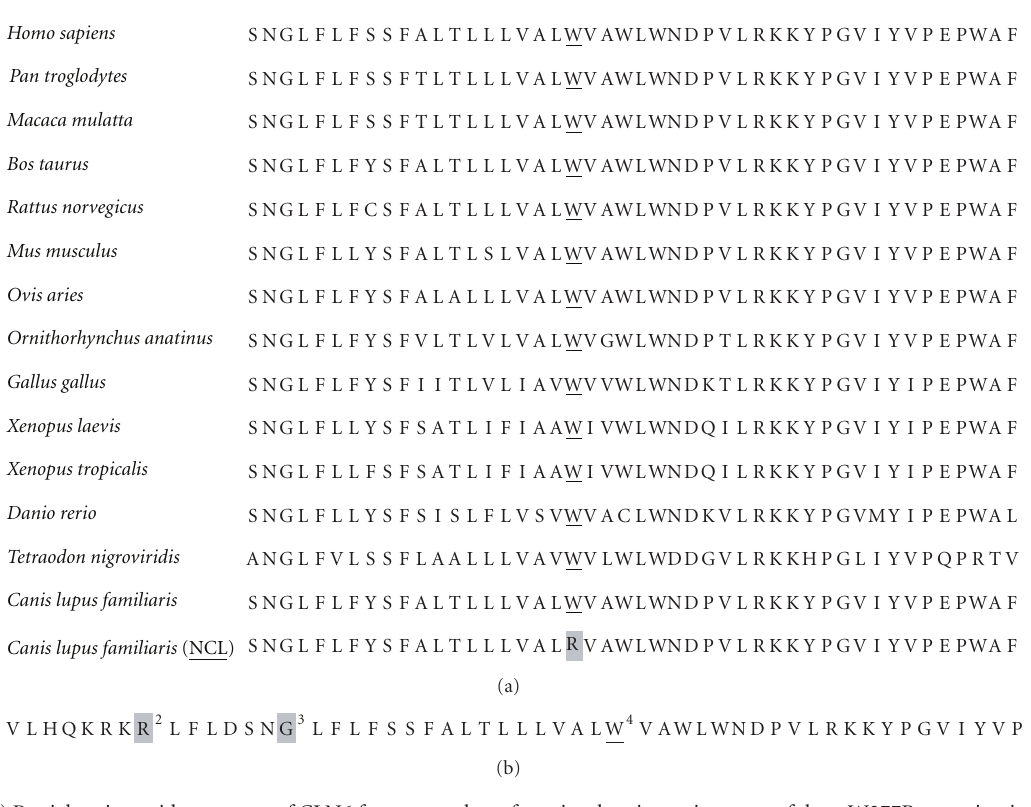
Figure 4: (a) Partial amino acid sequences of CLN6 from a number of species showing uniqueness of the p.W277R mutation in the a ff ected Australian Shepherd. (b) Partial amino acid sequence of human CLN6 showing missense mutation sites (shaded: p.M241T 1 ; p.R252H 2 ; pG259C 3 ; p.P299L 5 ; p.W300R 6 ) that result in human vLINCL and the amino acid corresponding to the Australian Shepherd mutation (underlined: p.W277R 4